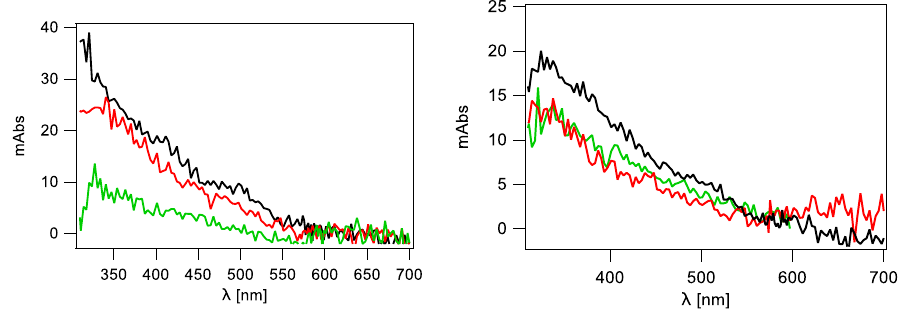
Figure 5. Transient absorption spectra recorded using ICCD in N 2 O-saturated phosphate buffered (50 panel) ct-DNA, at natural pH: ( − ) 1 µ s, ( − ) 50 µ s, and ( − ) 1 ms after electron mM) aqueous solutions containing (left panel) a mixture of four nucleosides (see text) and (right panel) ct-DNA, at natural pH: ( − ) 1  s, ( − ) 50  s, and ( − ) 1 ms after electron pulse.